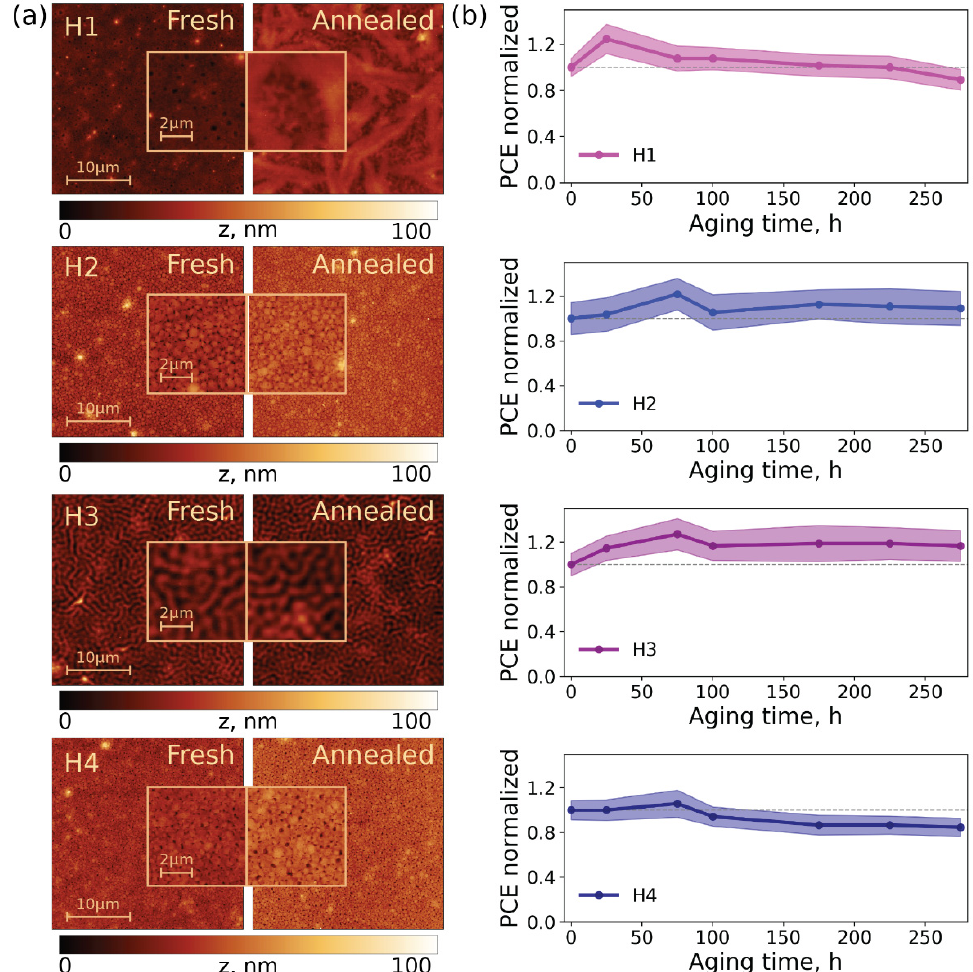
Figure 5. 30 × 30 µm AFM scans (insets: the magnified 6 × 6 µm area) of freshly prepared and annealed at 60 °C tri-layer stacks glass/perovskite/ H1-4 /metal oxide ( a ); evolution of efficiency of PSCs with H1-4 ( b ).